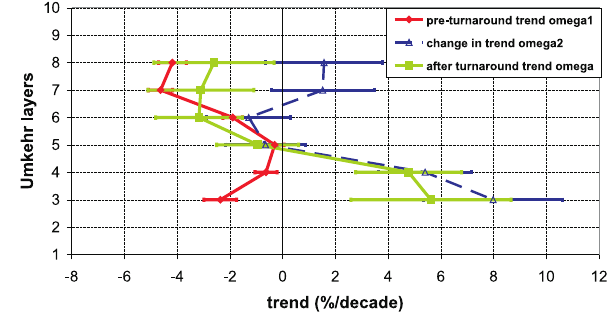
Fig. 4. Vertical distribution of year round ozone trend estimates in %/decade deduced from Umkehr measurements at Arosa using the double trend model. The pre-turnaround trend estimates are in red, the change in trend estimates are in blue and those after the turnaround are in pink. The statistical model includes QBO, so- lar cycle and the equivalent latitude proxy as explanatory variables. The equivalent latitude proxy accounts for dynamics related ozone variability. The error bars denote 2-sigma standard errors. The layer 3 represents the sum of layers L2 and L3 while the layer 8 repre- sents the sum of layers L8, L9, and L10 (adapted from Zanis et al.,